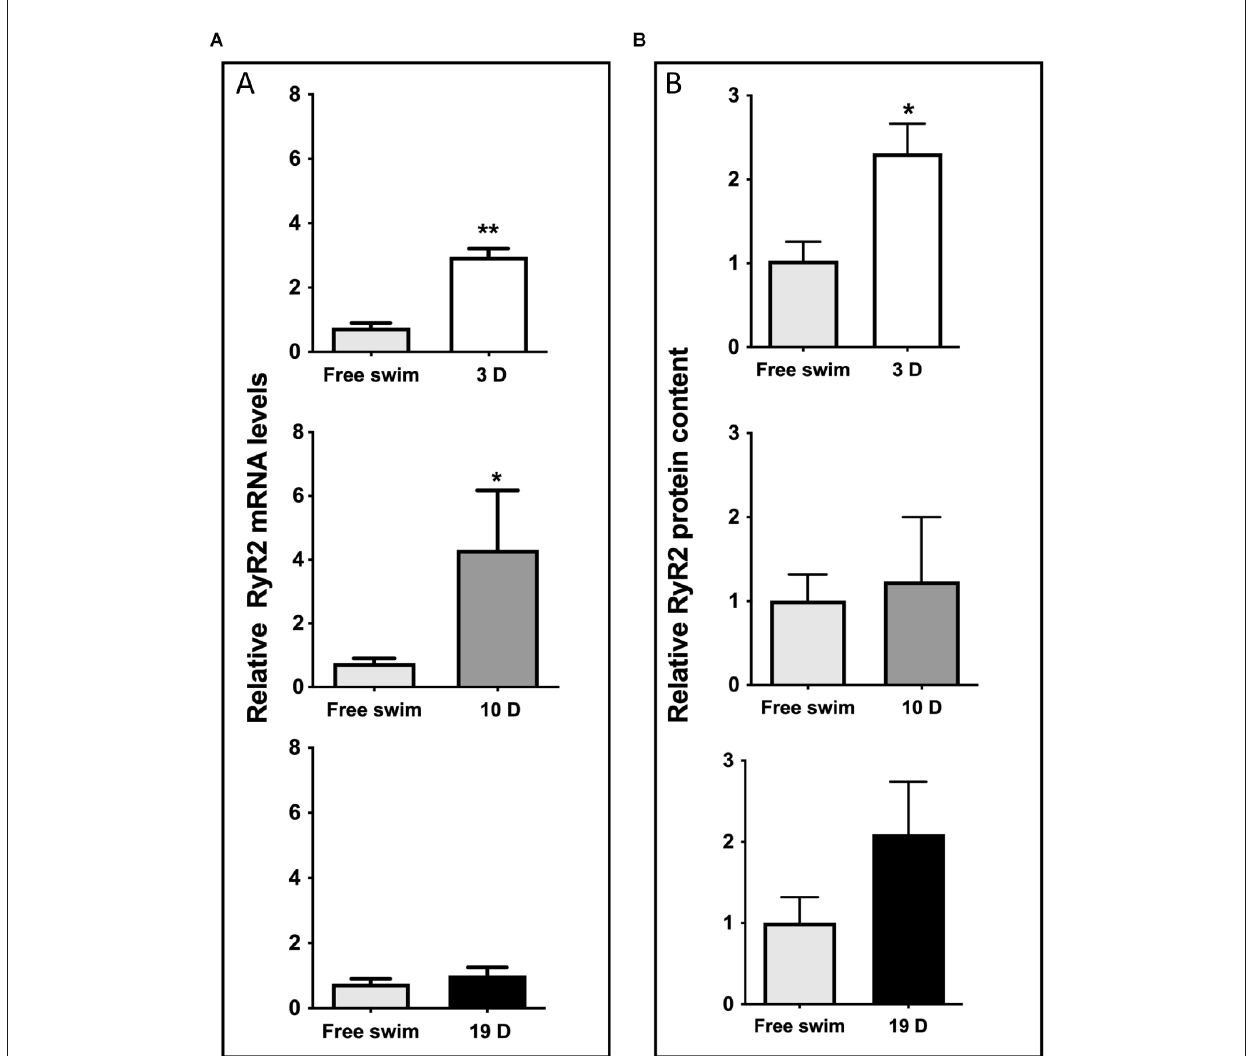
FIGURE4 Spatial memory training increased RyR2 mRNA levels and protein content. (A) qRT-PCR analysis of RyR2 mRNA expression levels, normalized with β -actin and obtained from the whole hippocampal tissue after the free swim sessions or 3, 10 or 19 days after the end of the training period. The bars represent the analysis of a group of N = 6 free swim rats; N = 5 rats were evaluated after 3 days; N = 5 rats were evaluated after 10 days and N = 4 rats were evaluated after 19 days. Values represent Mean ± SEM; ** p < 0.005. Results were analyzed with unpaired Mann-Whitney test. (B) RyR2 protein contents in hippocampal tissue collected after the free swim sessions 3, 10 or 19 days after the end of the training period; β -actin was used as loading control. Densitometry analysis of Western blots revealed significant increments in RyR2 protein content 3 days after training.